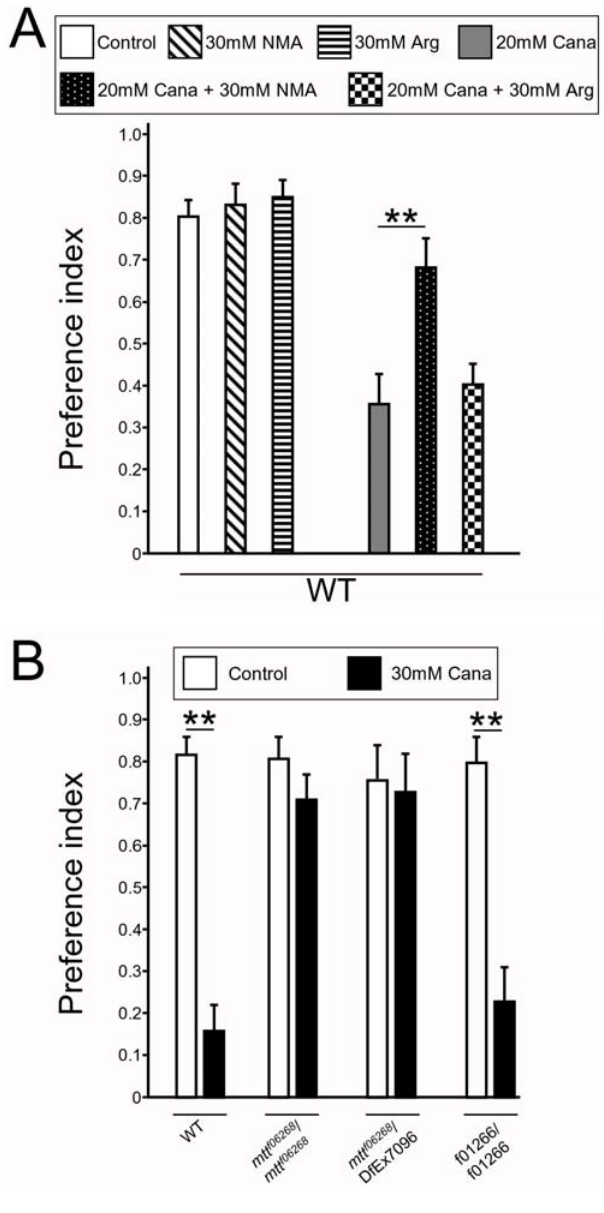
Figure 3. The L -canavanine–induced repulsive behavior re- quires the DmXR function. (A) Pharmacological inhibition of DmXR by the NMA antagonist reduces L -canavanine repulsive effect. Histograms show the preference index (PI) for the blue solution from two-choice feeding assays in which drugs have been added to the blue solution. There was no significant difference in the behavior of WT flies (WT) that fed similarly on the blue control solution (white) and on the blue solution containing either 30 mM NMA (diagonally hatched) or 30 mM L -arginine (Arg) (horizontally hatched). Significantly more flies fed on the blue solution containing 20 mM L -canavanine (Cana) + 30 mM NMA (dotted) than on the blue solution containing 20 mM L - canavanine (grey). L -arginine (30 mM) had no effect on 20 mM L - canavanine repulsive effect (checkered). Error bars indicate SEM. Asterisks indicate significant differences by t -test ( p , 0.001). (B) mtt mutant flies are insensitive to L -canavanine. Histograms show the preference index (PI) for the blue solution from two-choice feeding assays by using the blue solution without (white) or with (black) 30 mM L -canavanine. WT and the genetic background control f01266 / f01266 flies are strongly repulsed by L -canavanine and avoid feeding it. In contrast, mtt f06268 /mtt f06268 and mtt f06268 /DfEx7096 mutant flies are insensitive to L -canavanine, as they fed similarly on the blue solution